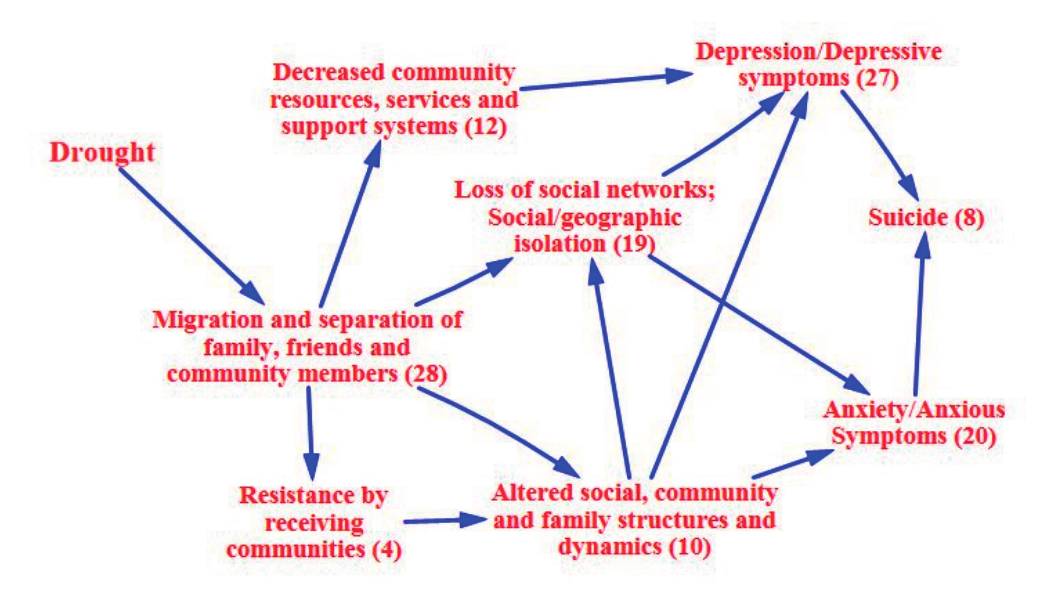
Figure 4. Mental health outcomes of economic effects of drought.